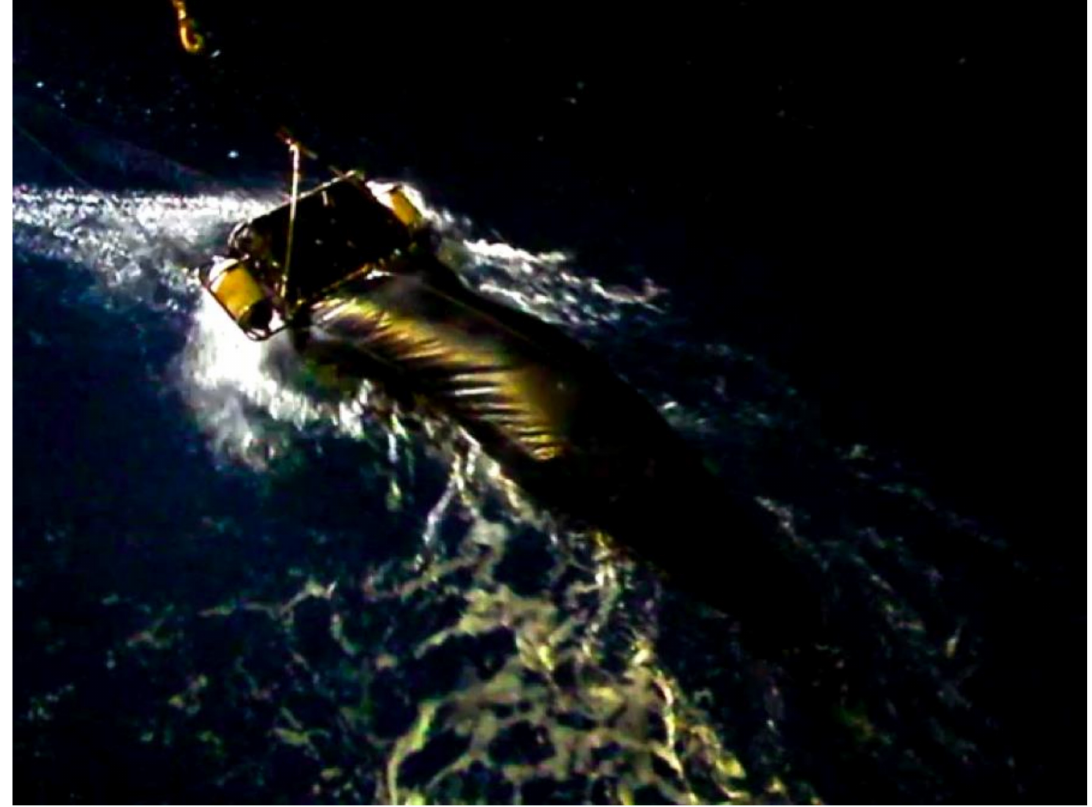
Figure 1. The nets used for sampling were Neuston nets modified from Manta type nets with a width of 1.3 m and length of 6 m with buoys on both